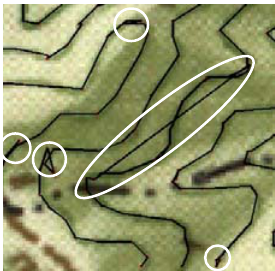
Figure 13. Vectorization result of Figure 11 by MAPGIS ( locally enlarged